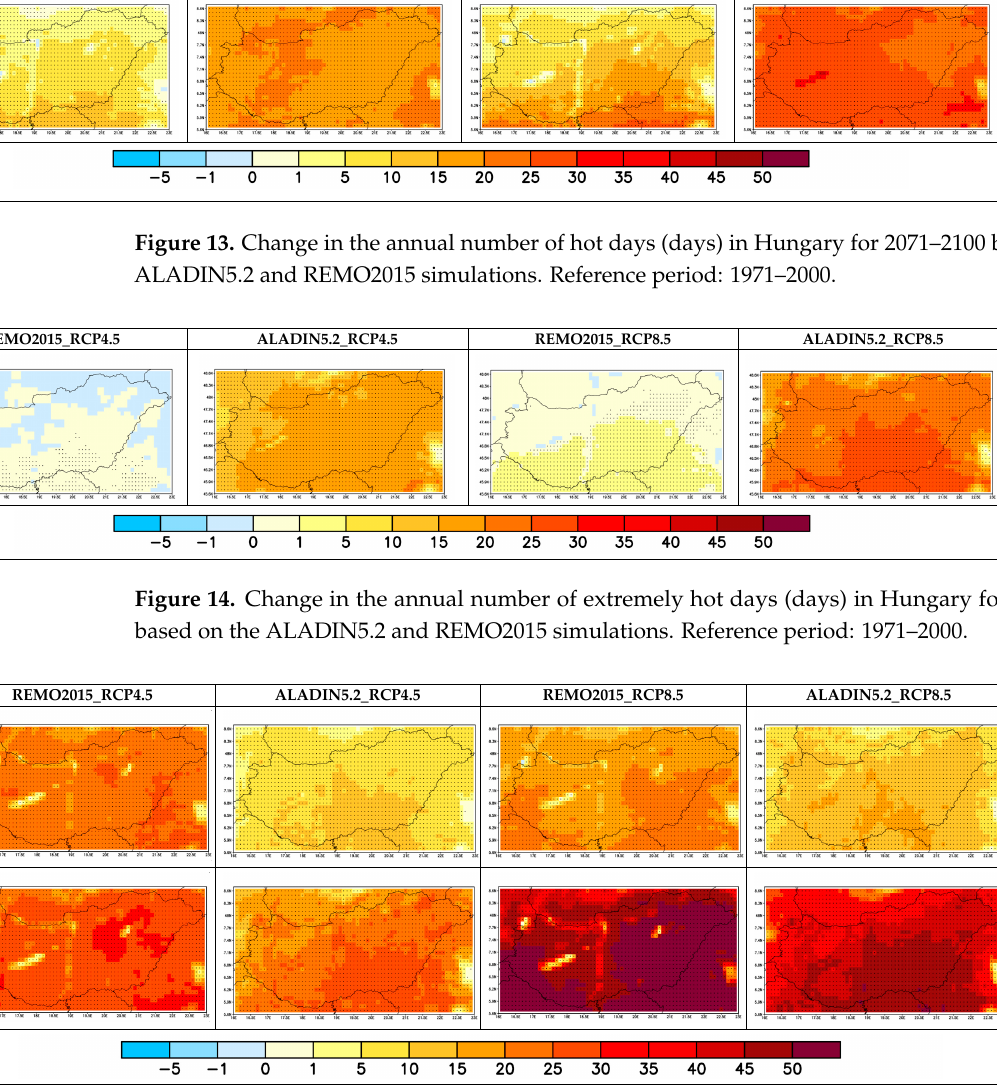
Figure 15. Change in the annual number of tropical nights (days) in Hungary for 2021–2050 and 2071–2100 based on the ALADIN5.2 and REMO2015 simulations. Reference period: 1971–2000.